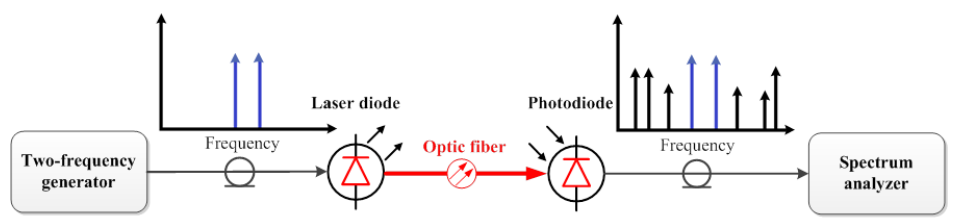
Fig. 1. Structural diagram for assessing the level of intermodulation distortion of radio signals in a fiber line using a two-frequency